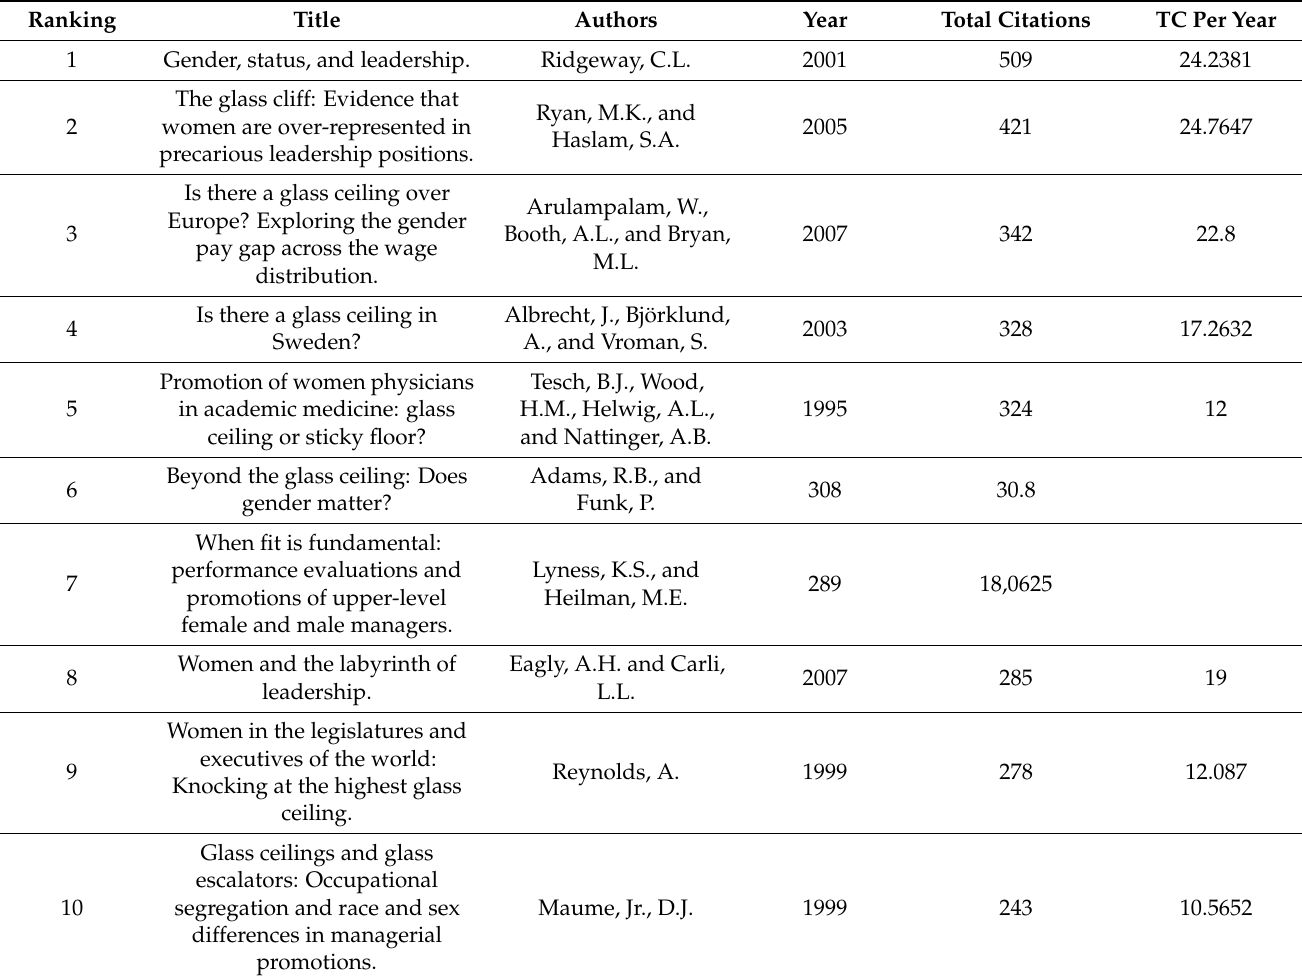
Table 3. Top 10 most cited